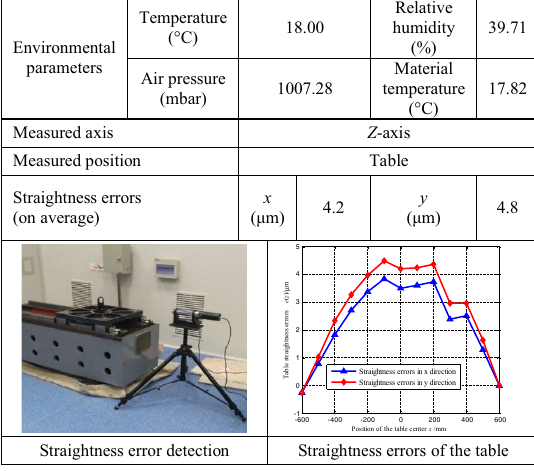
Environmental parameters